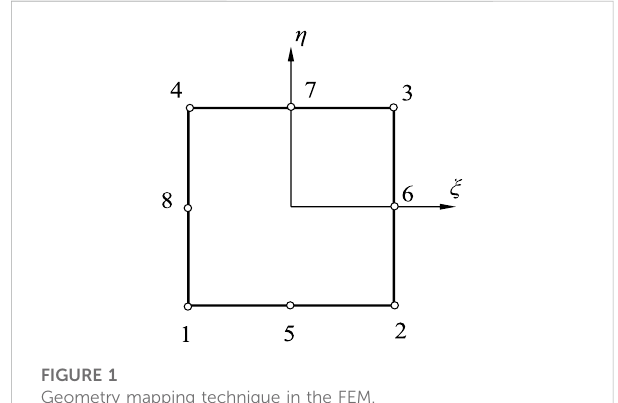
FIGURE 1 Geometry mapping technique in the